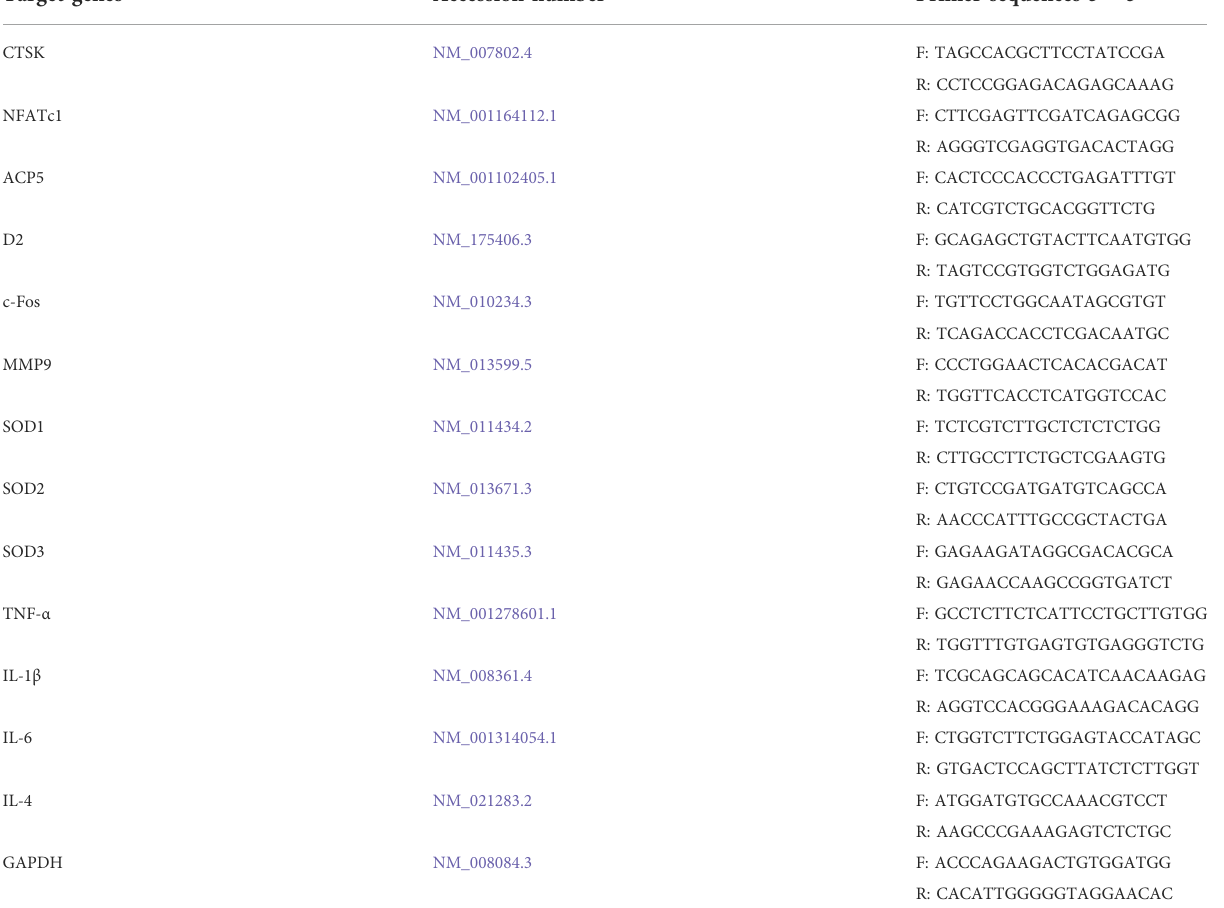
TABLE 1 Gene primer sequences used in